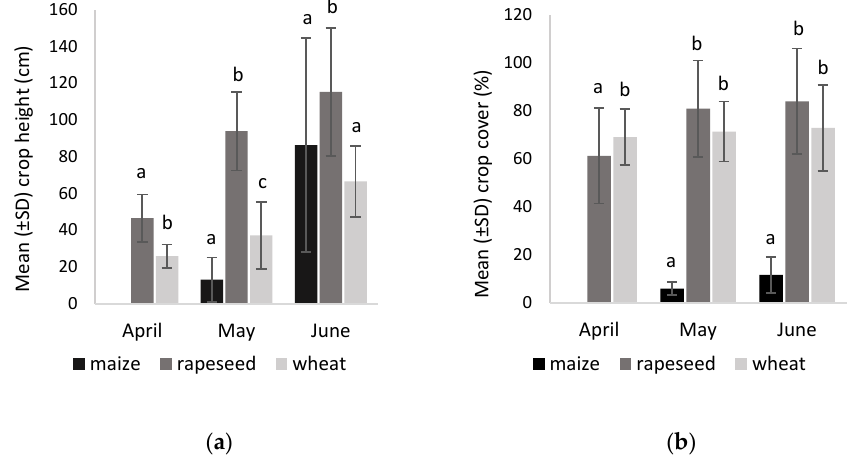
Figure 2. Comparison of ( a ) mean crop height and ( b ) crop cover among crop types in individual months. Vertical lines represent the standard deviation (SD). Superscripts indicate significant differences between the crop types in each month, based on Tukey’s post ‐ hoc tests. There was no difference in the height ( χ 2 = 0.30, p = 0.582) and cover ( χ 2 = 1.88, p = 0.170) between the center and edge parts of the study sites in wheat (Figure 3) and the same applied for both height ( χ 2 = 0.25, p = 0.619) and cover ( χ 2 = 2.24, p = 0.135) in maize (Figure 3). Only in the case of rapeseed, height ( χ 2 = 4.20, p = 0.041) and cover ( χ 2 = 28.50, p < 0.001) had significantly lower values at the edge of the study sites than in the center (Figure 3). ( b ) Figure 3. Comparison of ( a ) mean crop height and ( b ) mean crop cover in each crop type at different distances from the edge of the field. Vertical lines represent the standard deviation (SD). Super ‐ scripts indicate significant differences between the edge and center for each crop type, based on Tukey’s post ‐ hoc tests. 3.2. Insecticide Applications There were considerable differences in the number and timing of insecticide applica ‐ tions across the studied crops. In maize, insecticides were not applied even once during the observed period. In wheat, on the other hand, insecticides were applied at the begin ‐ ning of each monitored month (April—June). In rapeseed, insecticides were applied in March (before the start of monitoring), in the first half of April and, in 2019, in the first half of May (Table 1). 020406080100120140 wheat